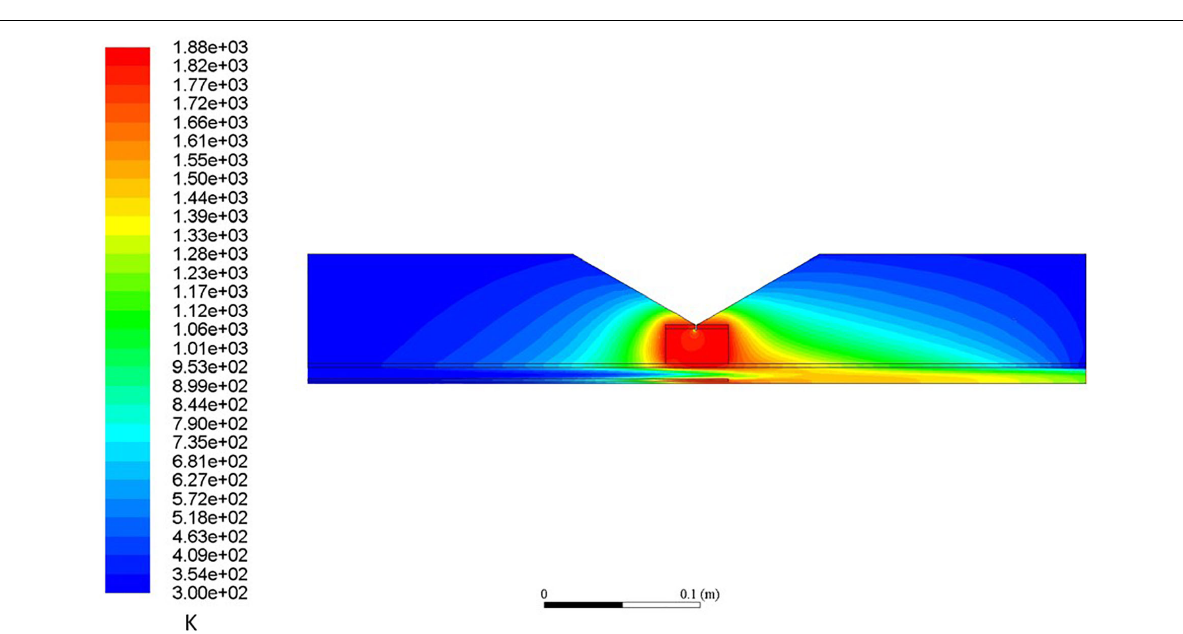
FIGURE 5 | Temperature contour for the dual tube configuration (270 mm)